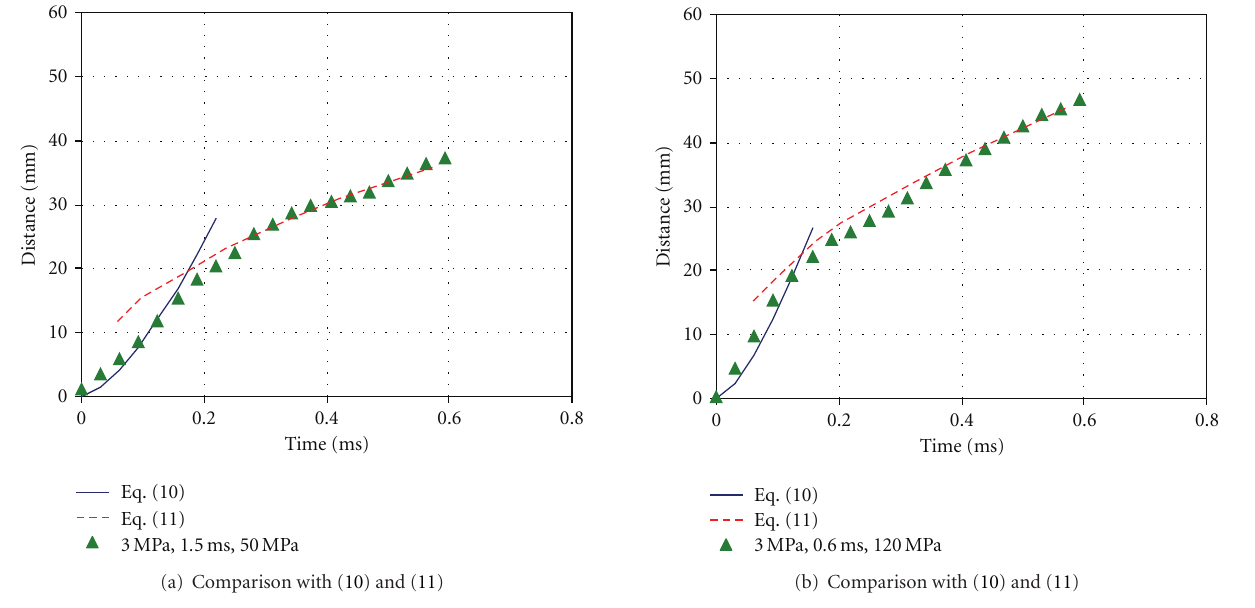
Figure 12: Comparison of experimental results with (10) and (11), Nozzle D.